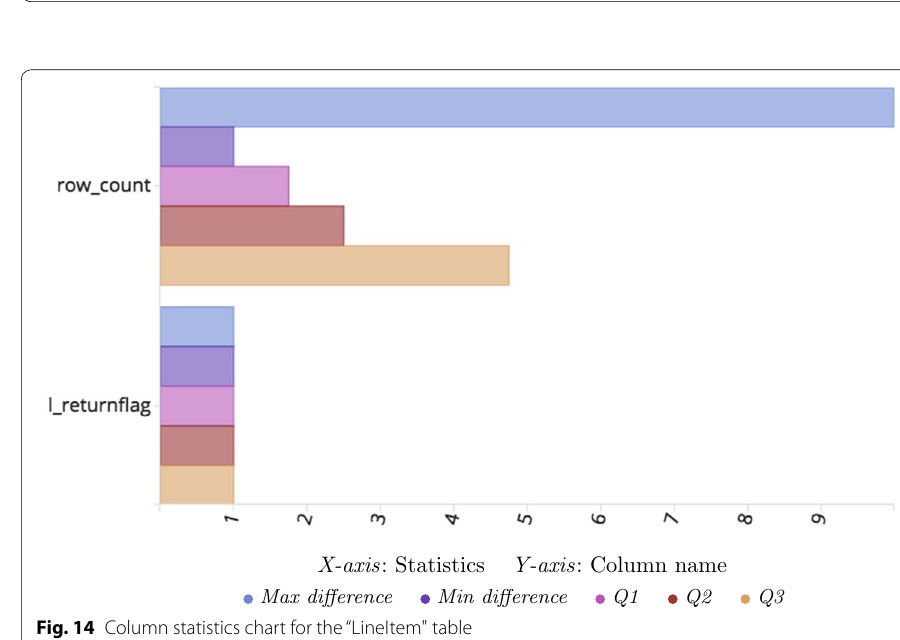
Fig. 14 Column statistics chart for the “LineItem" table